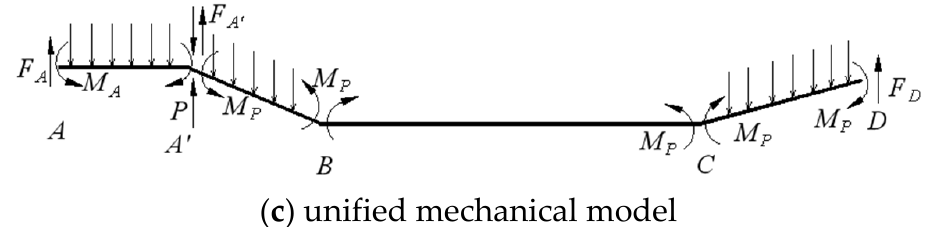
Figure 4. Mechanical model of strip plate.